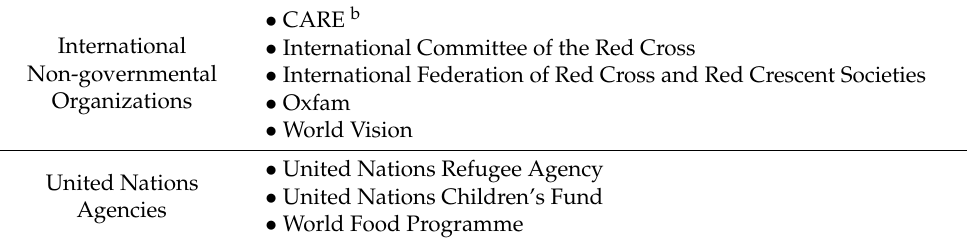
Table 1. Non-state actors included in the review of interventions addressing food insecurity in